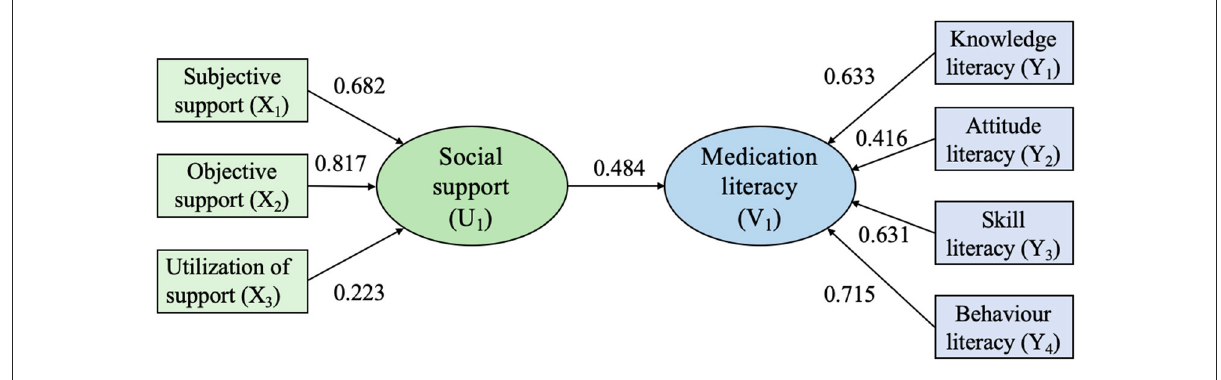
FIGURE1 Conceptual model for the canonical correlation.